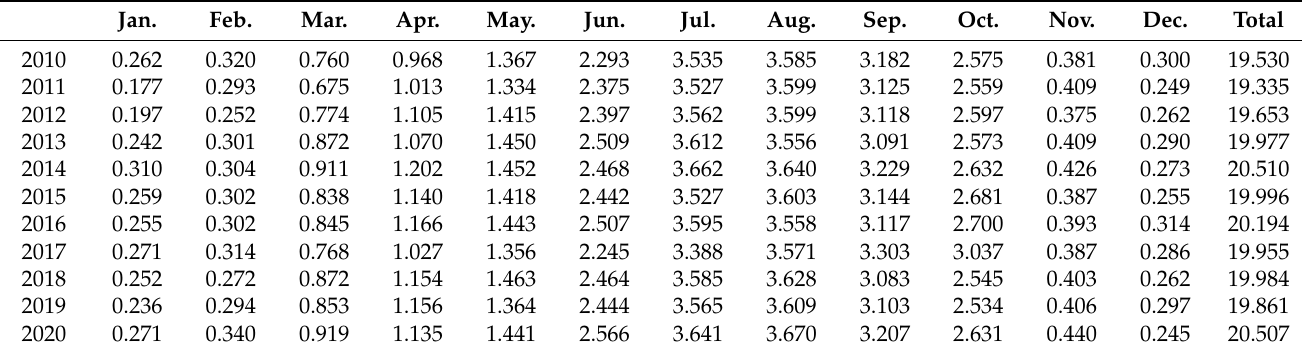
Table 5. Table 5. Monthly and total CH 4 emissions from terrestrial ecosystems in China, 2010 – 2020.